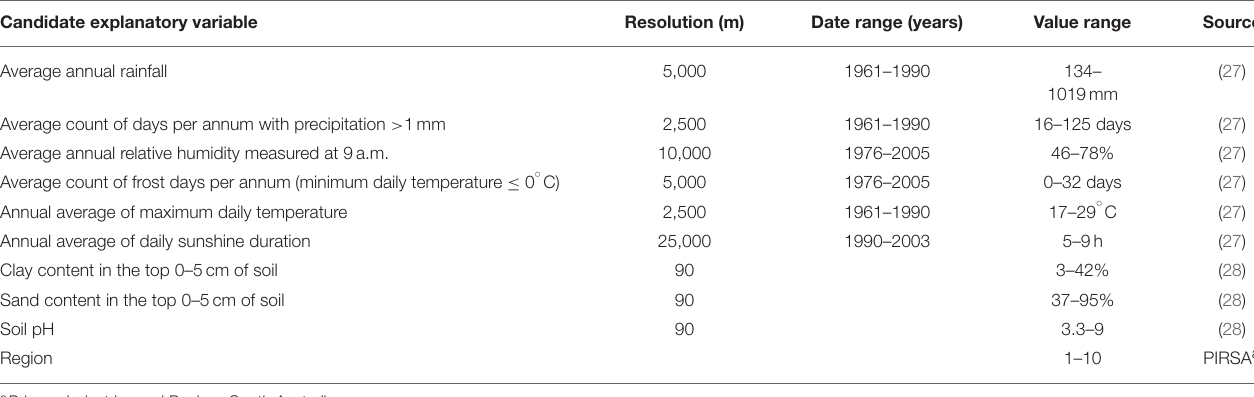
TABLE 1 | Candidate explanatory variables hypothesized to influence the distribution of sarcocystosis. Candidate explanatory variable